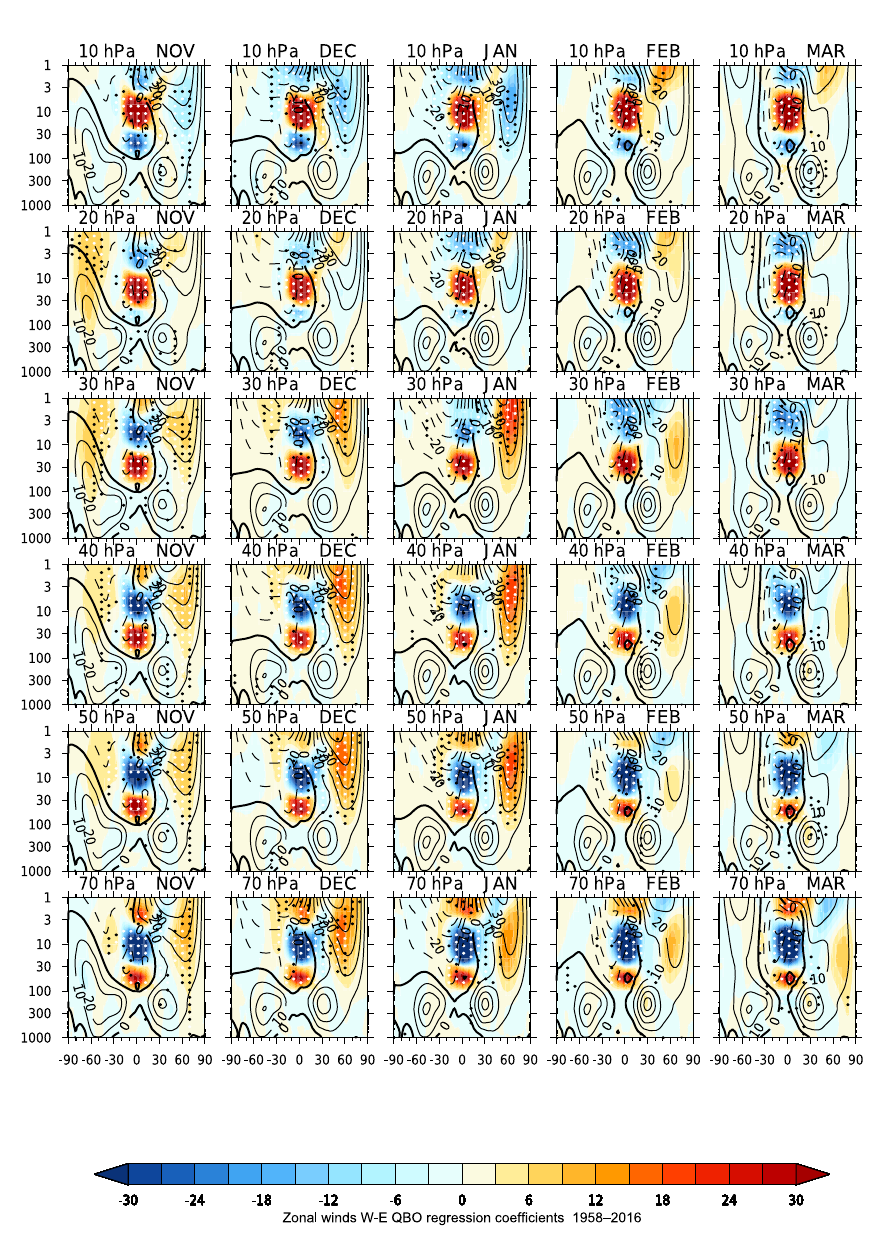
Figure 3. Regression-based QBO-W minus QBO-E differences: height–latitude cross sections of zonally averaged zonal winds (ms − 1 ) for November–March (columns) from the period 1958–2016. The rows show results for the QBO defined by equatorial zonal wind time series U eq at different pressure levels from 10 to 70hPa. Contours show the climatological values (interval of 10ms − 1 and the thick line is the zero value). White (black) dots indicate 99% (95%) statistical